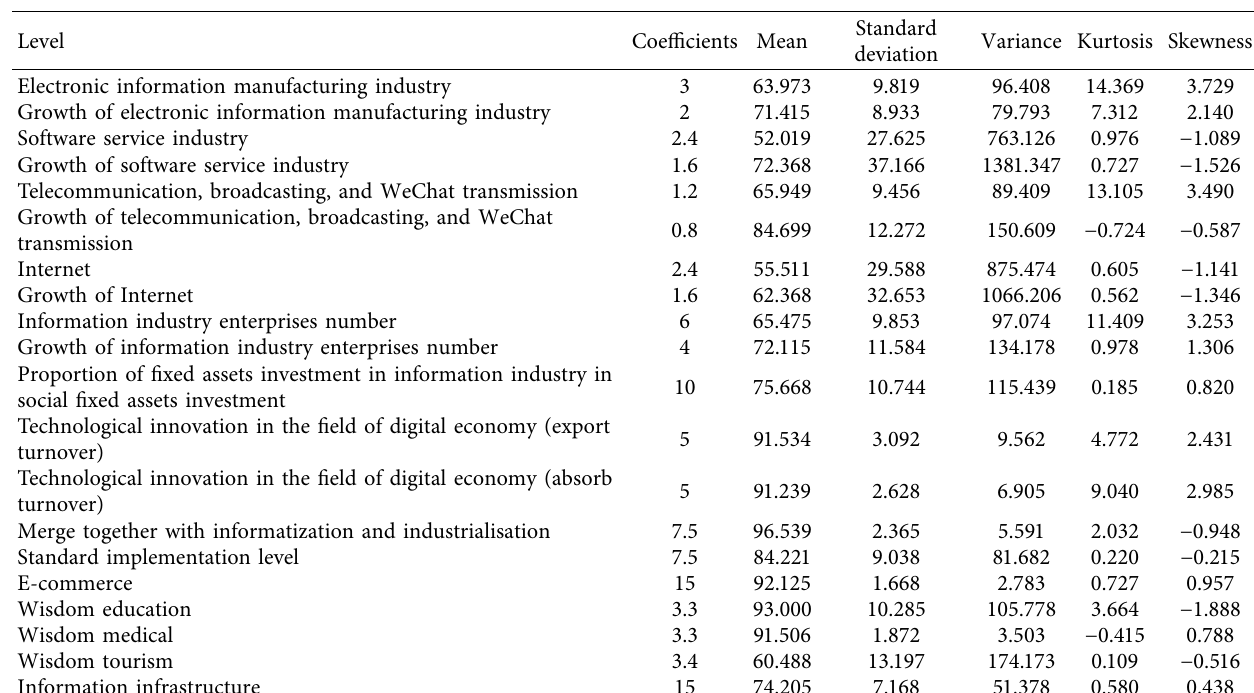
Table 2: Weights of the second level.